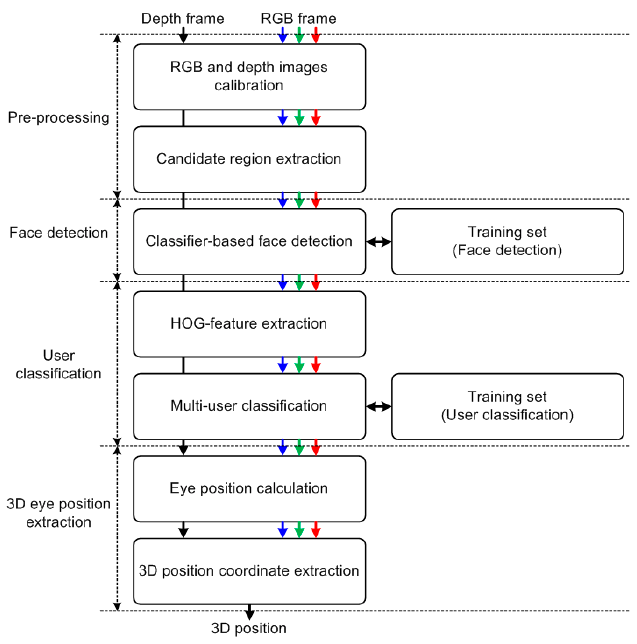
Figure 3. Overall block diagram for the proposed algorithm.